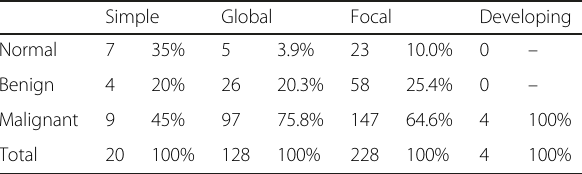
Table 2 Correlation between the type of asymmetry and its